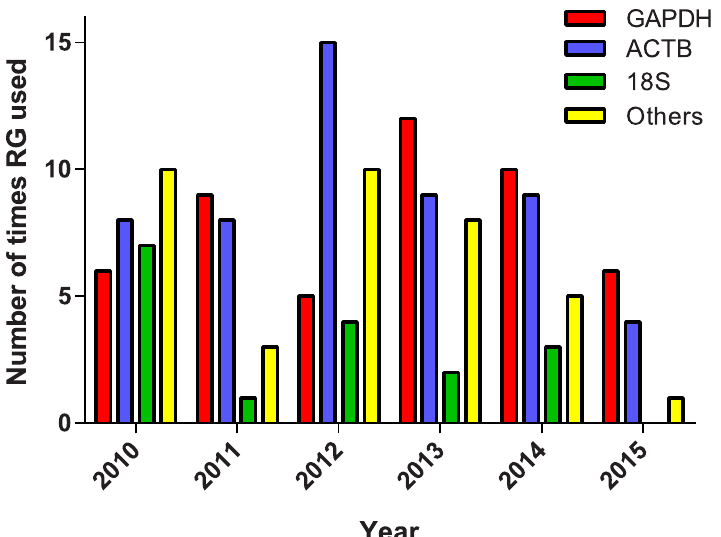
Fig 3. Utilisation of GAPDH and ACTB and 18S rRNA as RGs in gene expression studies since the publication of the MIQE guidelines.